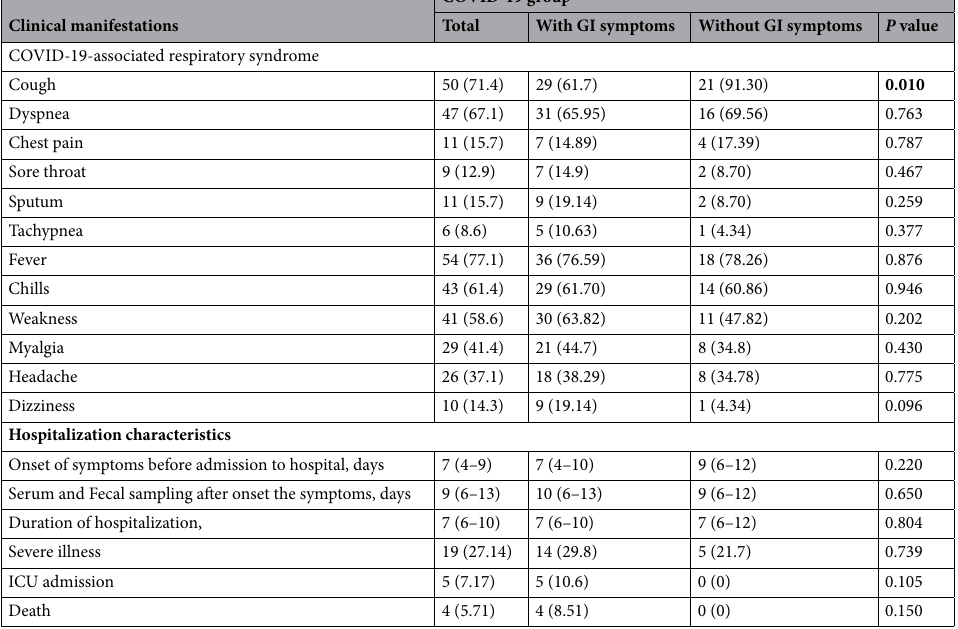
Table 2. COVID-19 patients’ features. Data are presented frequency (percentage) or median and 25th and 75th percentiles (P25–P75) for variables with non-normal distribution. Bold font indicates statistical significance at the P value < 0.05